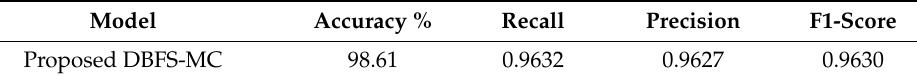
Table 8. Performance of the proposed DBFS-MC.